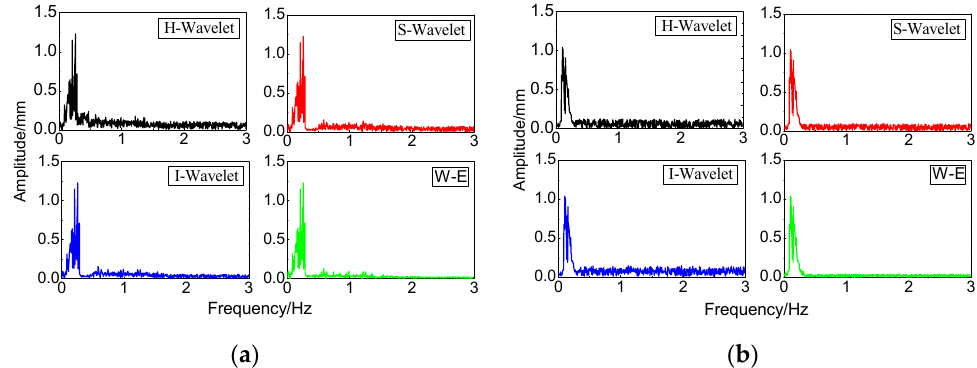
Figure 10. Comparison of denoising results from the four methods in the frequency domain: ( a ) horizontal direction and ( b ) vertical direction.